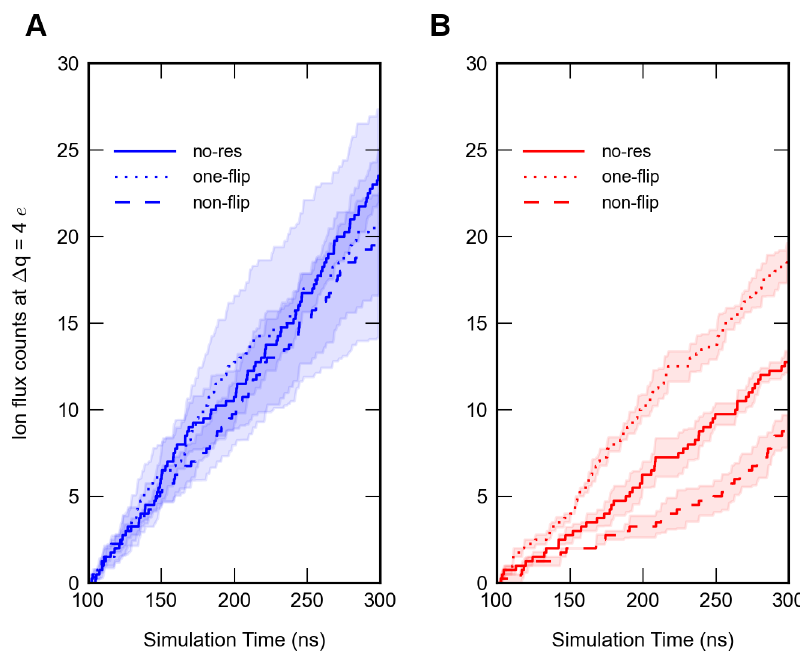
Figure 8. Influences of different flipping states at D q= 4 e (n=4). A) Average ion flux counts through the SF over time of inward conduction (color: blue). The simulations without restraints of E53 are depicted as solid line, the ones with the ‘‘one-flip’’ restraints are shown as dotted line and the ones with the ‘‘non-flip’’ restraints are shown as dashed line. B) Average ion flux count through the SF over time of outward conduction (color: red). Error estimations shown in the figure are S.E.M.